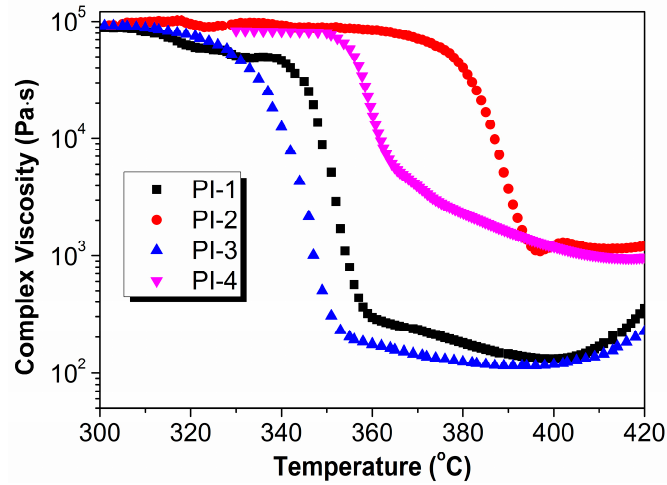
Figure 10. The melt viscosities as a function of temperature for polyimides.